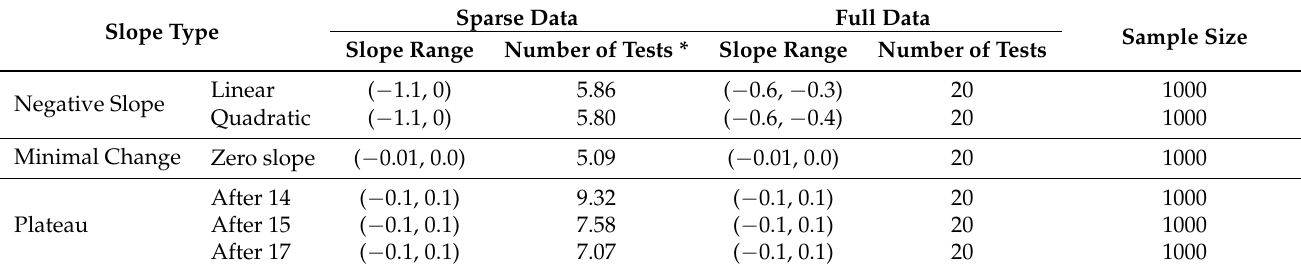
Table 1. A summary of the simulation parameters.